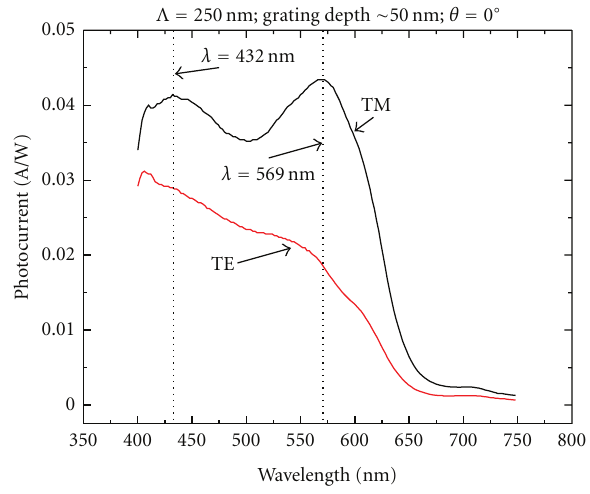
Figure 5: The TE and TM photocurrent responses of the P3HT- PCBM layer as a function of wavelength with Λ = 250nm and at normal